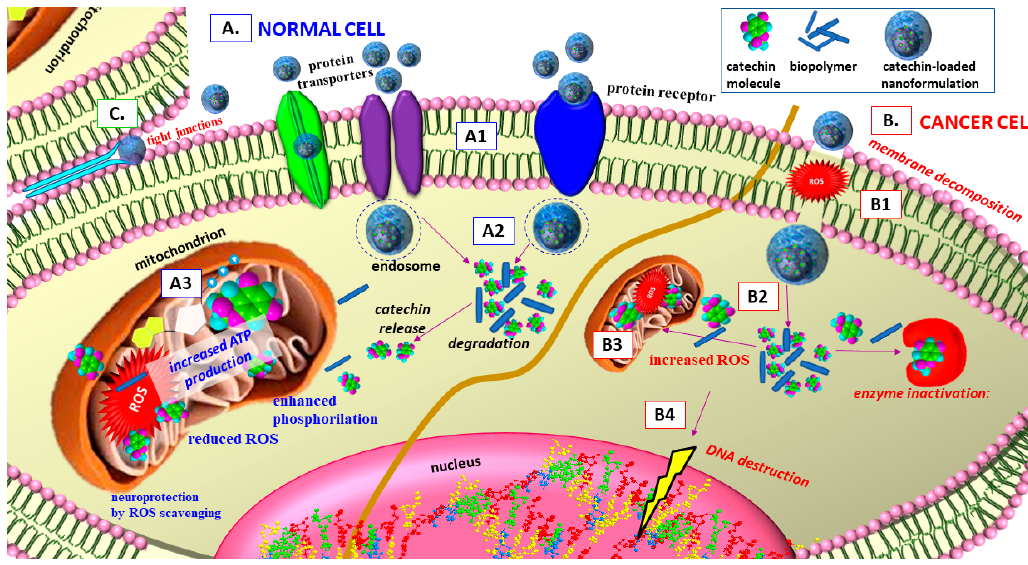
Figure 8. Catechins-loaded biopolymer nano formulations antioxidant / pro-oxidant / antiproliferative presumptive pathway and activity in intra- and inter-cellular environment of normal and cancer cells [7,11,22,52,58,71,94,95,101,107–111]: ( A ). In intracellular normal cell environment: ( A1 ).Diffusivetransportviaproteintransporters,( A2 ).Intracellulardegradationofthebioflavonoid / biopolymer composite, subsequent catechins release, ( A3 ). In mitochondrion environment. ( B ). In intracellular cancer cell environment: ( B1 ). Entrance into the cancer cell, ( B2 ). Intracellular degradation, subsequent catechins release, ( B3 , B4 ). Increased ROS production, ( B5 ). Inactivation of enzymes. ( C ). In intercellular environment: